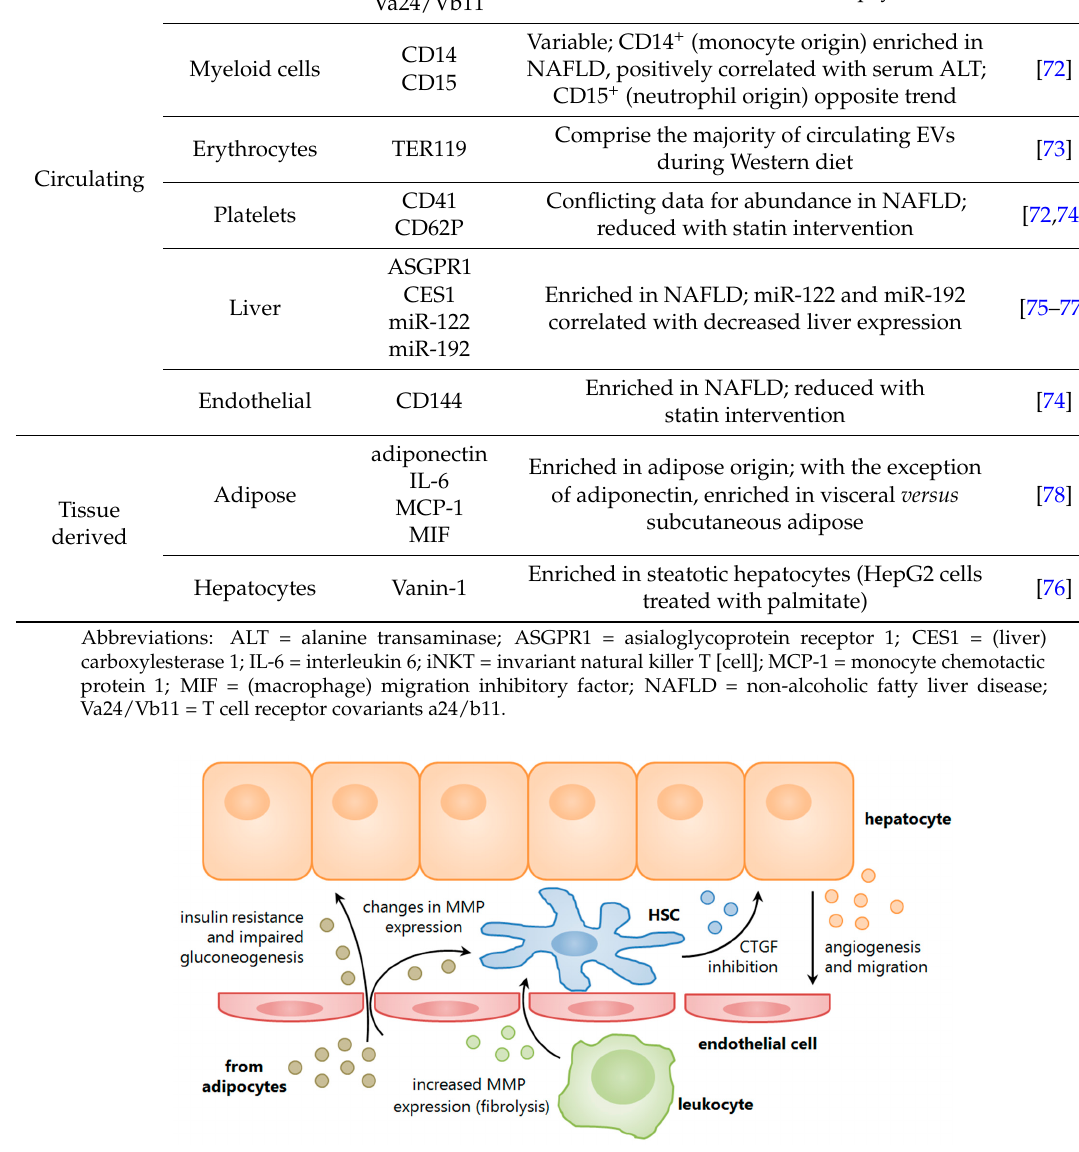
Table 1. Extracellular vesicle markers in non-alcoholic fatty liver disease (NAFLD) studies. Vesicle Source Marker(s)